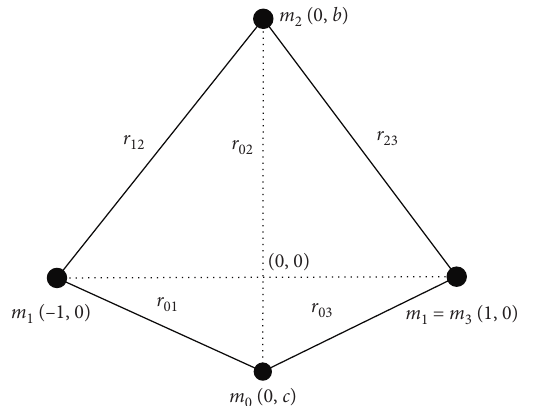
Figure 6: Convex four-body kite configurations with two equal � m ) masses ( m 1 3